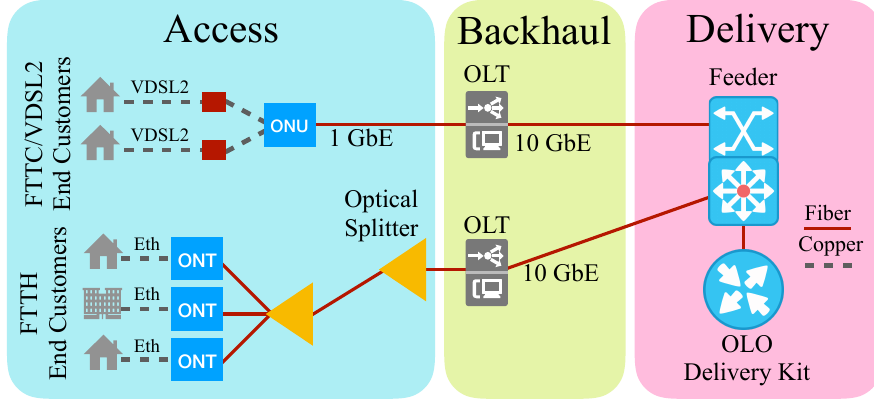
Figure 2. NGA Bitstream